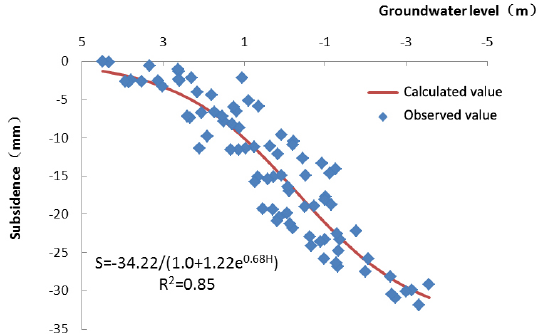
Figure 1. The relationship between groundwater levels and land subsidence in the stratum 66–94m below the ground surface.